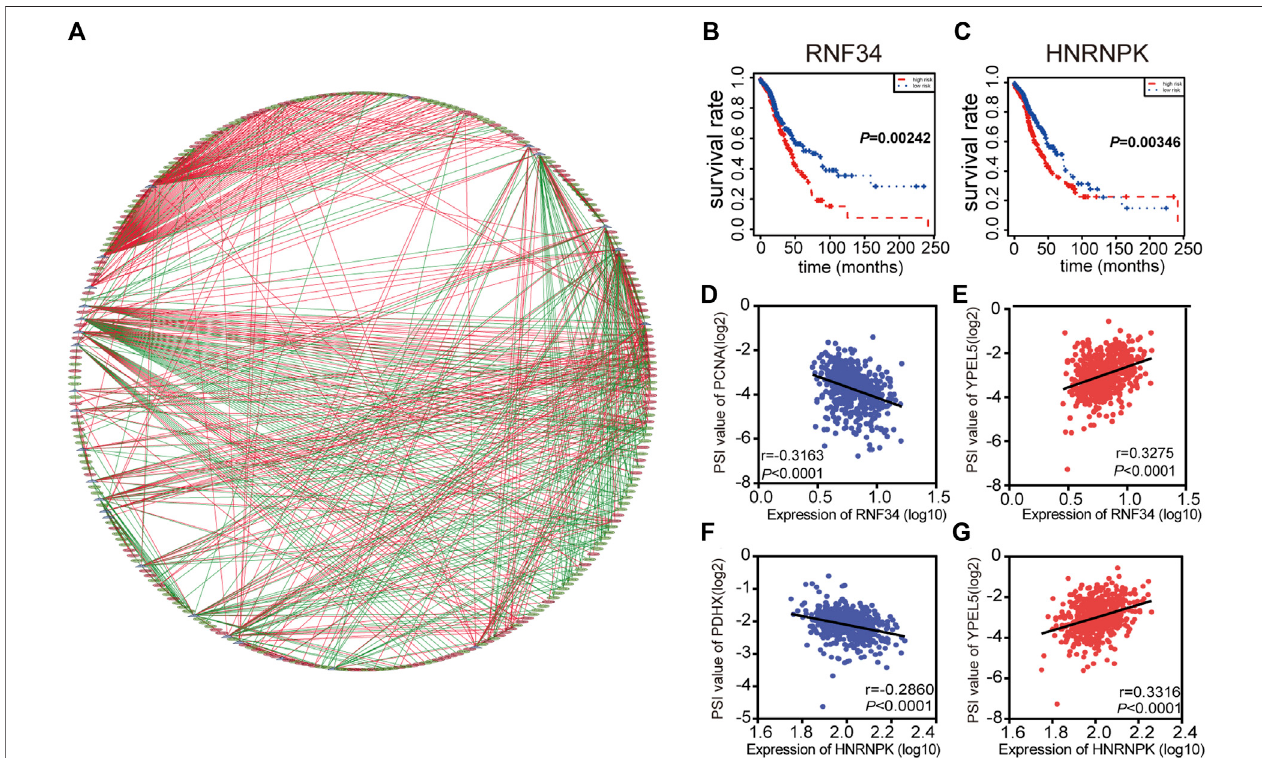
FIGURE 4 | Splicing correlation network in LUAD. (A) Correlation network between expression of survival Splicing factors and PSI values of AS genes generated usingCytoscape.Purpledotsweresurvivalassociatedsplicingfactors. Green/Reddotswerefavorable/adverseASevents.Red/Greenlinesrepresent positive/negative correlations between substances. (B – C) Kaplan-Meier curve of splicing factors RNF34 and HNRNPK. (D – G) Representative dot plots of correlations between expression of splicing factors and PSI values of AS events.